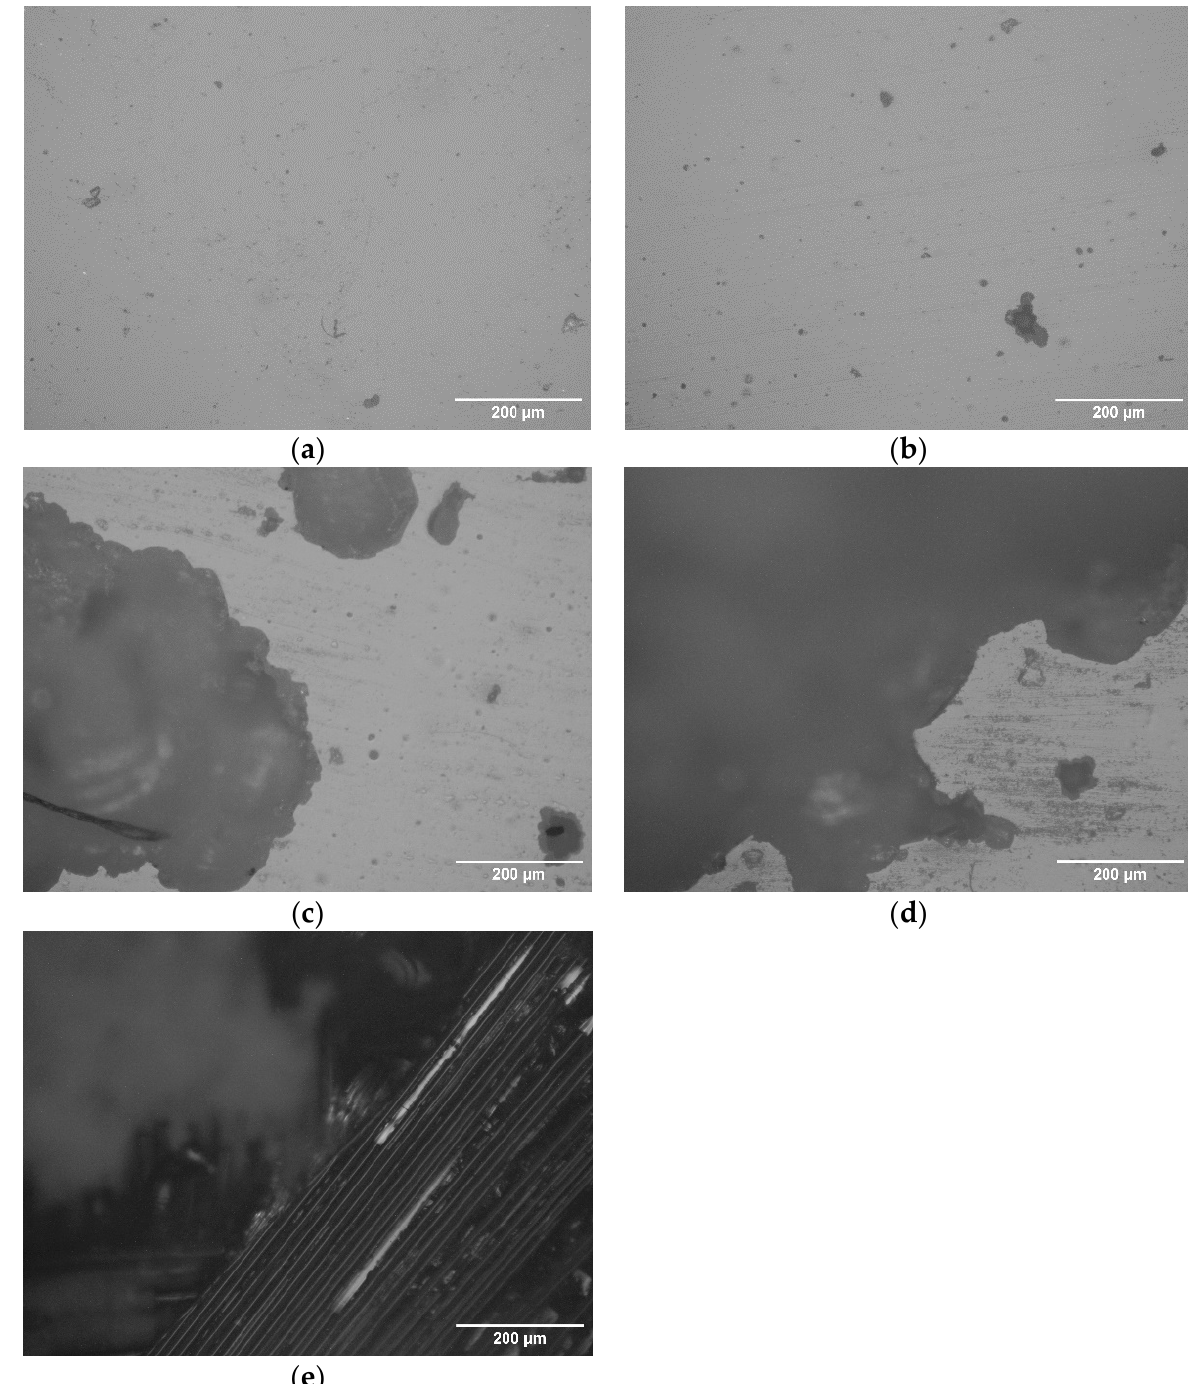
Figure 11. Microcopy image of representative sample with coating C at ( a ) stage 1; ( b ) stage 2; ( c ) stage 3; ( d ) stage 4; ( e ) stage